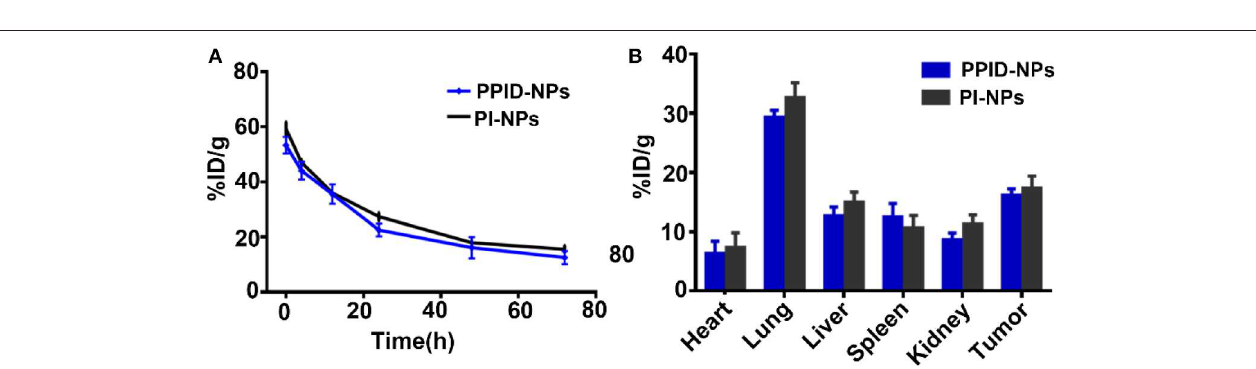
FIGURE 9 | (A) in vivo pharmacokinetic curves over a span of 72h after intravenous injection of PPID-NPs or PI-NPs. (B) Biodistribution of PPID-NPs or PI-NPs at 24h after the injection.